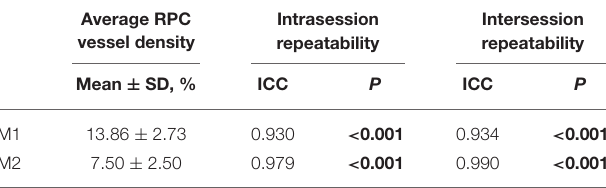
TABLE 4 | Factors associated with retinal nerve fiber layer thickness.